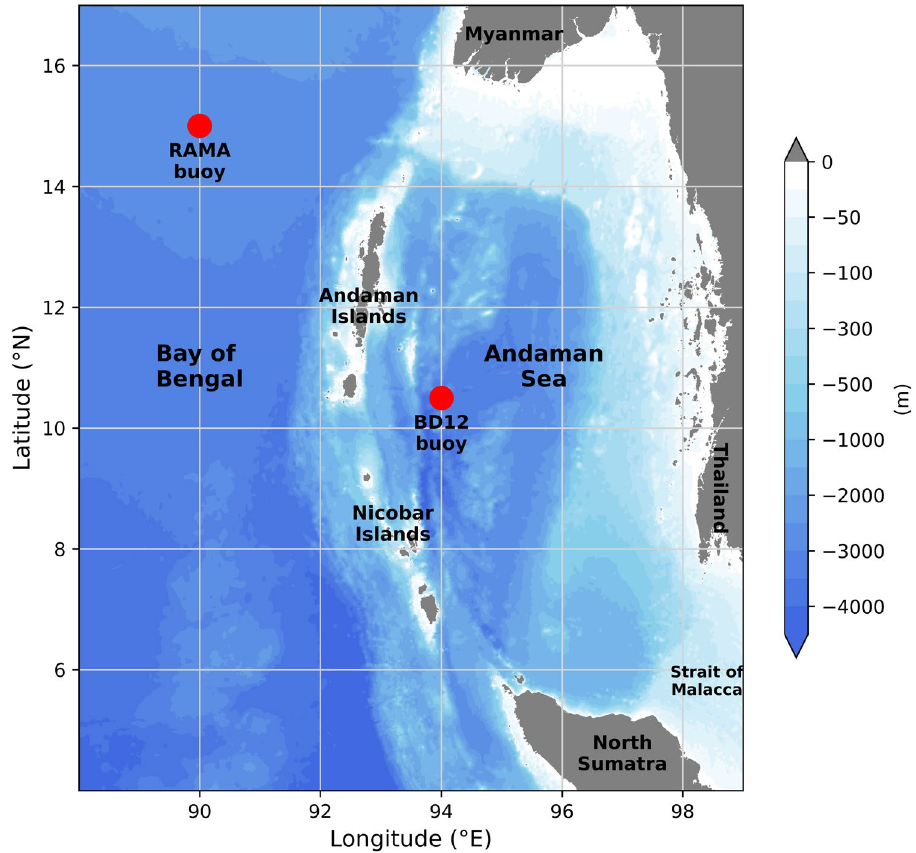
Figure 1. GEBCO bathymetry of MITgcm model domain along with the locations of RAMA buoy and BD12. The relevant copyright information can be found at https:// www. gebco. net/ data_ and_ produ cts/ gridd ed_ bathy metry_ data/ gebco_ 2019/ grid_ terms_ of_ use.